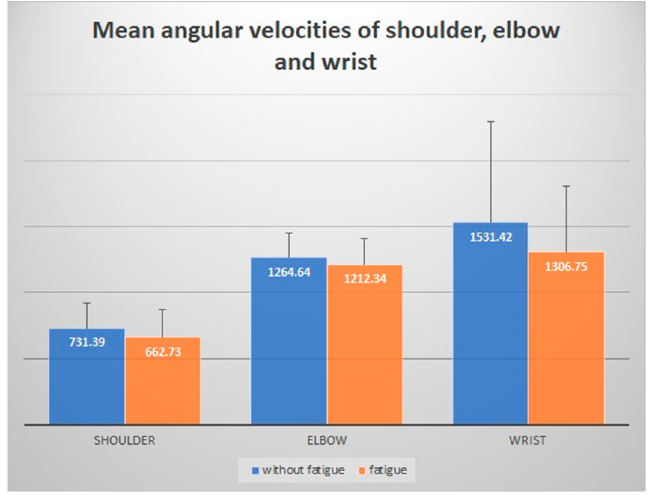
Figure 3. Comparison of angular velocities between fatigue and non-fatigue. In addition, the results in Table 1 indicated that there was a significant difference between fatigue and non-fatigue conditions in angular velocities in terms of shoulder (SHOULDER_AV max ; p = 0.01), elbow (ELBOW_AV max ; p = 0.04) and wrist (WRIST_AV max ; p = 0.01). In addition, there were significant differences in passing accuracy (ACCURACY; p = 0.01) and ball speed (BALL_S; p = 0.00) between fatigue and non-fatigue conditions; there were significant differences in the pelvis position (PELVIS_P; p = 0.00) and the pelvis velocity X-axis (PELVIS_X axis ; p = 0.00) between fatigue and non-fatigue conditions. How- ever, there was no significant difference in the pelvis Y-axis (PELVIS_Y axis ; p = 0.12). As presented in Table 2, the mean values of players’ HR and BL under the influence of fatigue were obviously higher than in non-fatigue condition (fatigue: HR = 186.82; BL = 10.35; non-fatigue: HR = 87.82; BL = 1.45).